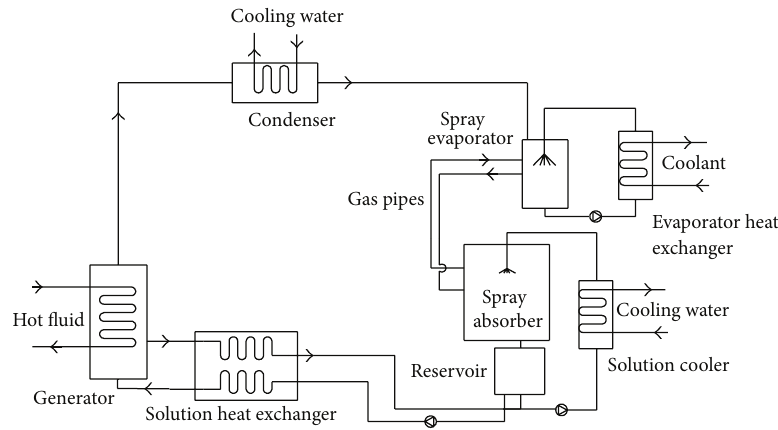
Figure 2: Diagram of flow chart of the novel